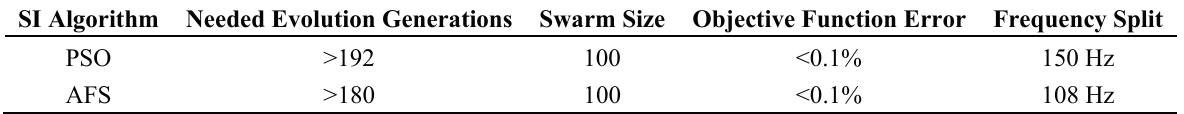
Figure 2. Results of the AFSA algorithm. ( a ) Objective function value versus generations; ( b ) Resonant frequencies obtained by calculation versus generations. Table 5. The comparison between PSO and AFS SI algorithms.